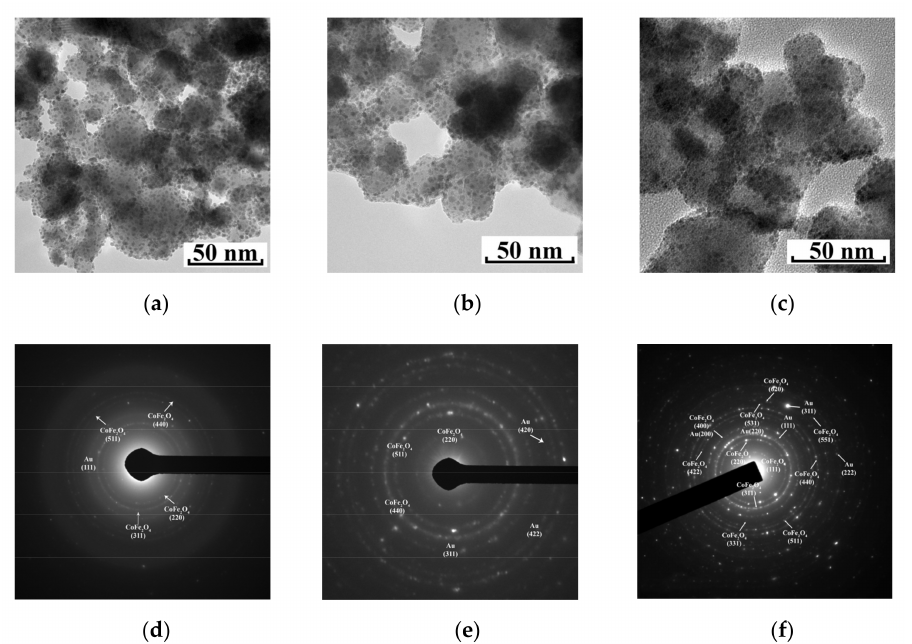
Figure 3. TEM images ( a – c ) and electron diffraction patterns ( d – f ) of CoFe 2 O 4 /Au nanoparticles after gold deposition from the alkaline (pH = 12) solution containing 0.03 mol/L HAuCl 4 and 0.03 mol/L methionine at 37 ◦ C for 4 h: ( a , d ) 1 gold deposition cycle, ( b , e ) 6 gold deposition cycles and ( c , f ) 10 gold deposition cycles.